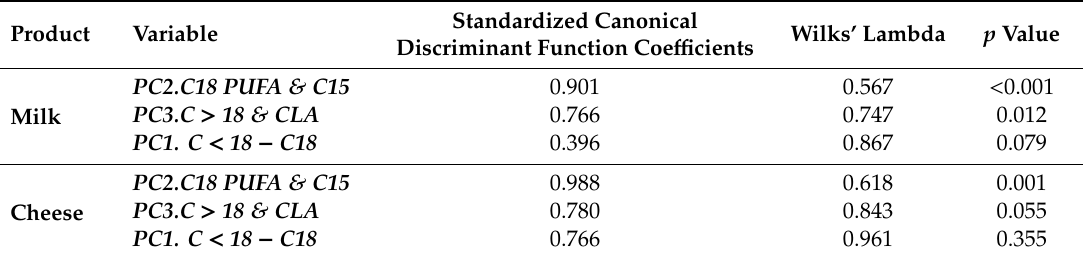
Table 4. Standardized canonical discriminant function coe ffi cients and Wilks’ lambda of variables included in the discriminant analysis to discriminate the fatty acids profile in milk and cheese from grazing and no grazing system.